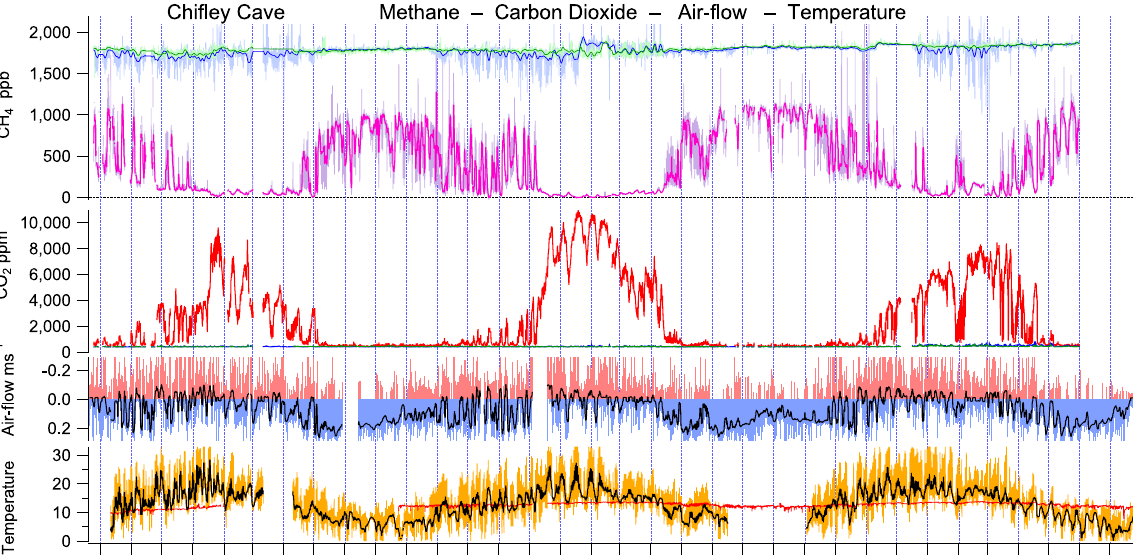
Figure 2. CH 4 and CO 2 CRDS continuous measurements (8 minute averages, recorded hourly) from LKB in Chifley Cave over 3 years from September 2012 to August 2015. Methane measurement error ± 20 ppb and carbon dioxide ± 5 ppm. Winter air-flow (blue infill) shows external ambient air drawn into Chifley Cave from the “Grand Arch” cave entrance has a greater velocity and longer duration than Summer air-flow (red infill) in the opposite direction. External weather has a direct immediate impact on cave CO 2 & CH 4 (eg. week 1 February 2015) linking cave trace gas composition to external weather and climate.